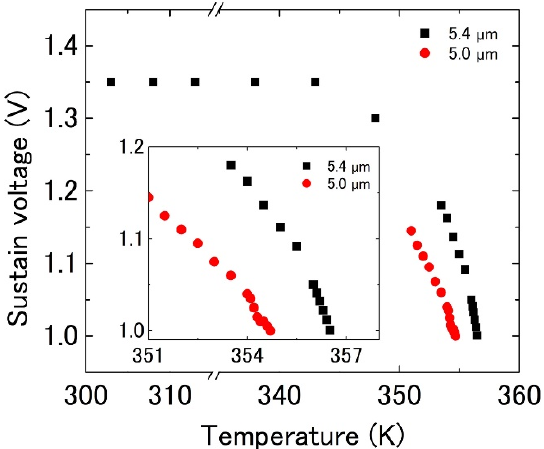
Figure 2. Sustain voltage for RTN structure as a function of temperature for cell thicknesses of 5.0 (red solid circles) and 5.4 µm (black solid squares). The insert shows an enlarged view of the high temperature region.